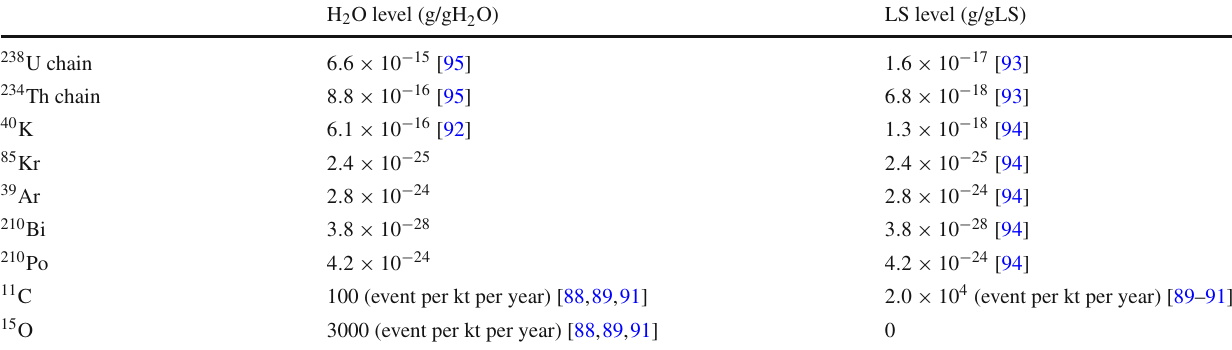
Table 3 Natural radioactive and cosmogenic background levels for the baseline detector